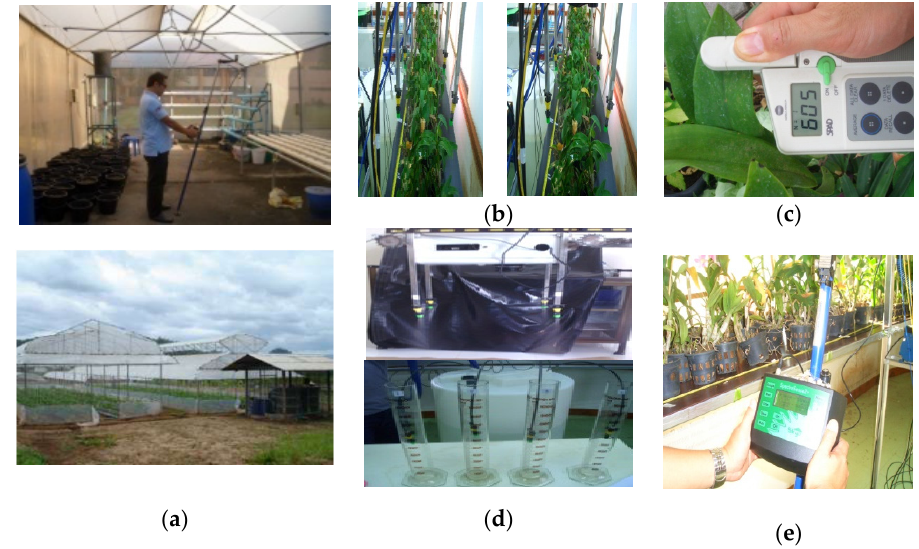
Figure 1. Experimental set up and field preparation, ( a ) Greenhouse; ( b ) Orchid plants; ( c ) Minolta SPAD 502 Meter (Konica Minolta Sensing Inc., Osaka, Japan) measuring plant leaves; ( d ) Calibration of volume flow rate control; ( e ) SKR 1800 (Skye Instruments, Ltd., Powys, UK) illumination